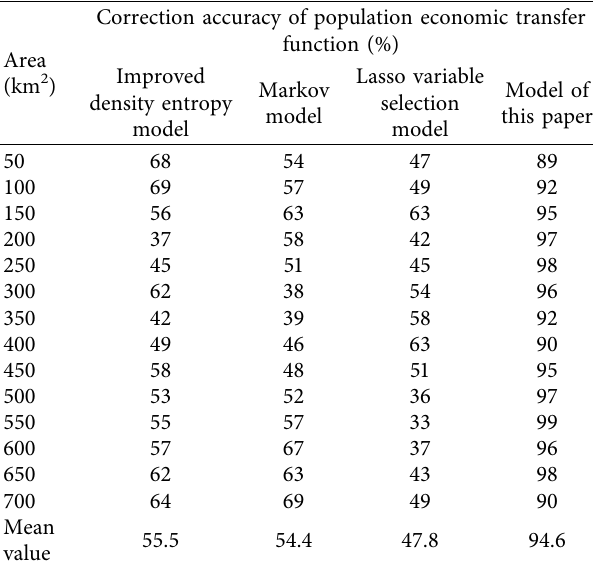
Table 3: Correction accuracy of population economic transfer function under different models. Correction accuracy of population economic transfer function (%) Area (km 2 )